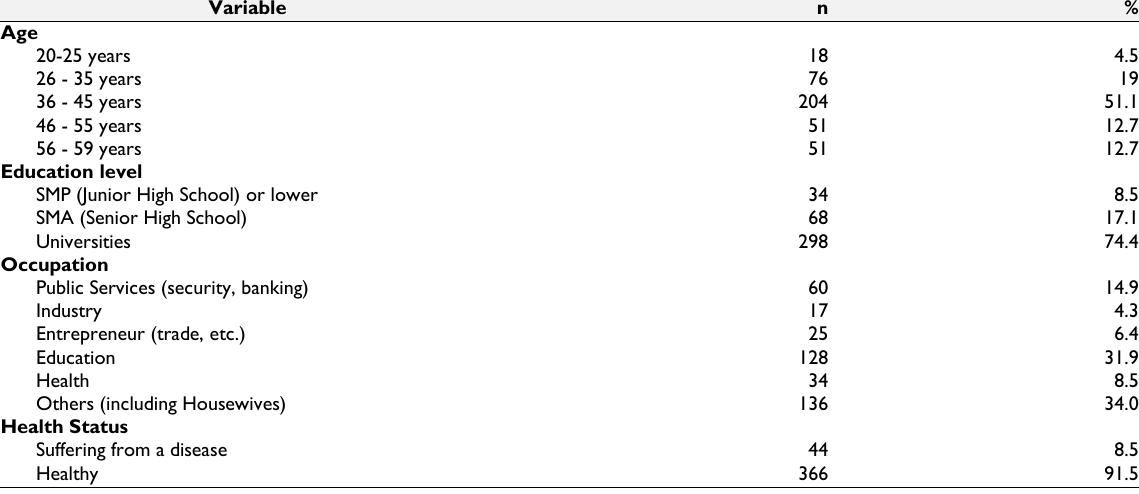
Table 1 Distribution of age, education, occupation, and health conditions (N = 400) Variable